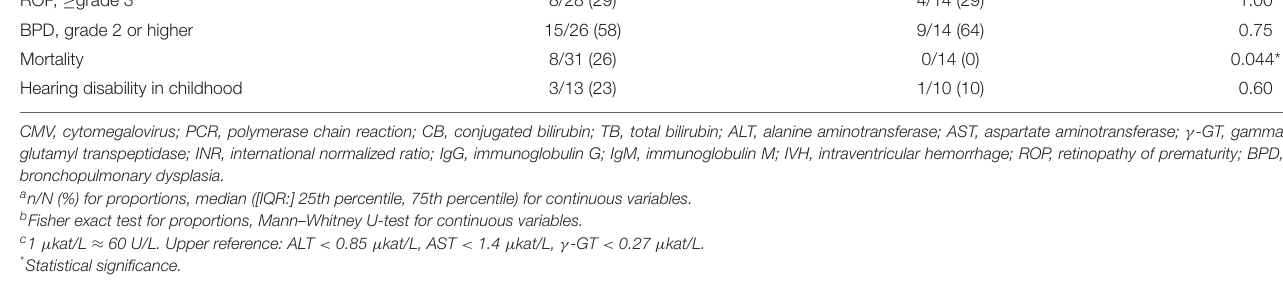
TABLE 4 | CMV and risk factors for cholestasis, multivariate analysis. Crude